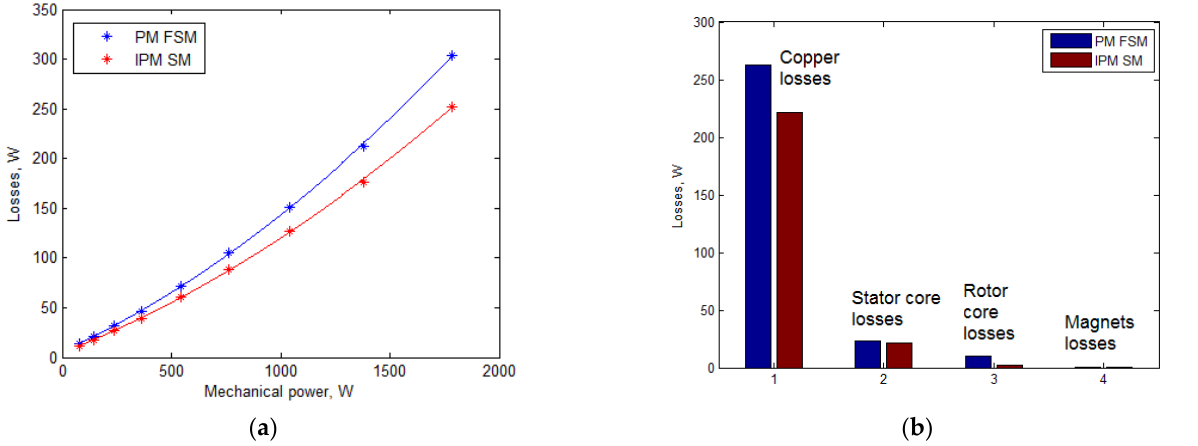
( b ) Figure 11. Comparative dependencies on mechanical power: ( a ) efficiency ( b ) torque ripple. The torque ripple in the IPMSG was quite low, namely, below 4%. Another revealed advantage of the PMFSG was a lower cost of rare-earth magnets. Particularly, the PMFSG required 1.4 times less rare-earth magnetic material than the IPMSG. Considering that the mining of rare-earth materials and their manufacturing have a harmful effect on the environment, this advantage of the PMFSG is highly valuable for mass production [33]. Furthermore, Table 8 shows that the demand for copper in the PMFSG was twice lower than for the IPMSG. Consequently, the cost of active materials for the PMFSG was 1.4 times lower than for the IPMSG, mainly due to the reduction in the magnets mass. 7. Conclusions The aim of this study was to theoretically compare the PMFSG with a conventional IPMSG in a direct-driven low-power wind application. To ensure a fair comparison, both machines were first optimized using the Nelder–Mead algorithm. The optimization objective functions were selected so as to take into account the required power of frequency converter, the evaluation of the active materials cost, and losses in generators averaged over the working profile of the wind turbine. Additionally, the torque ripple was included in the optimization function of the IPMSG, since this parameter was significantly higher in the IPMSG than in the PMFSG. To reduce the computational time, the substituting profile method was applied. As a result, the strengths and weaknesses of the machines were revealed.